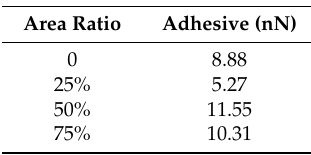
Table 1. Adhesive force of the nanopatterned surface with different area ratios. (An area ratio of 0 corresponds to a fat surface without nanopattern.)